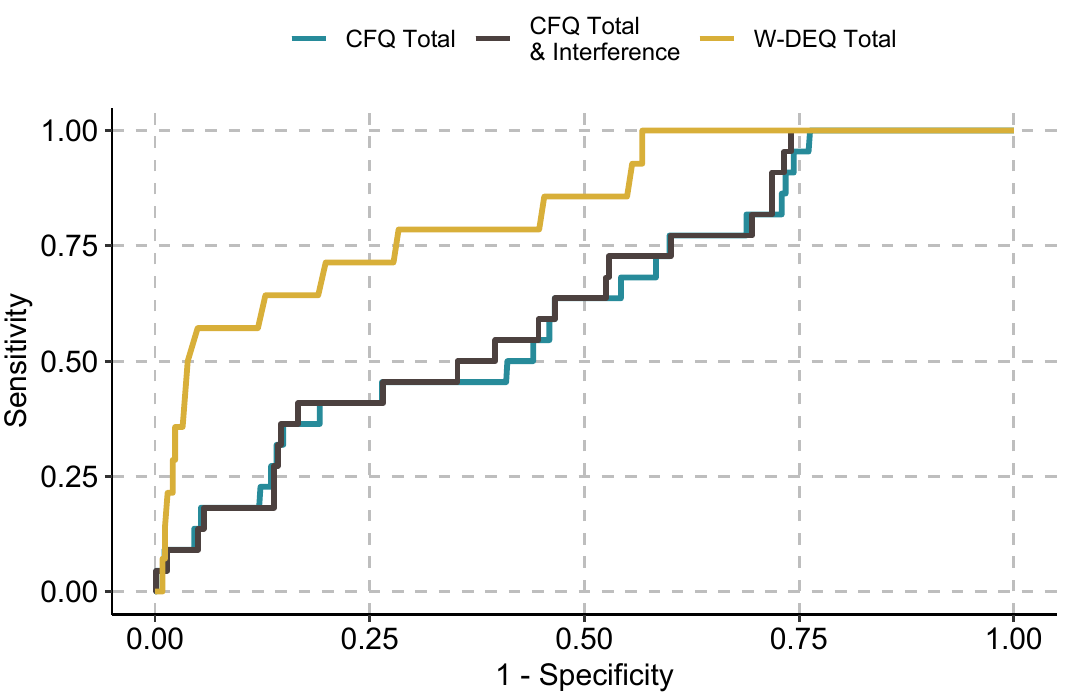
Figure 2. ROC curves for the CFQ and the W-DEQ for the full sample (subclinical and full diagnostic criteria combined).